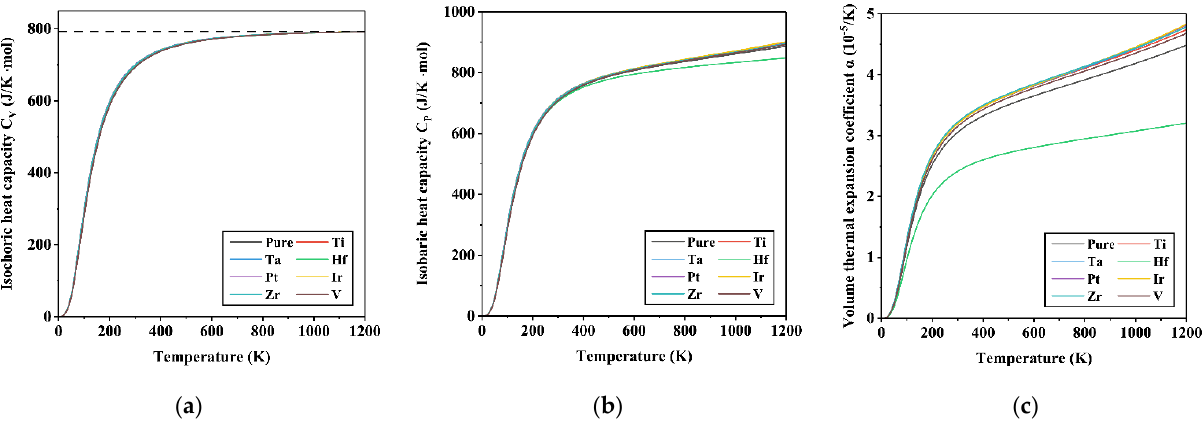
C ) and ( c ) volume thermal p